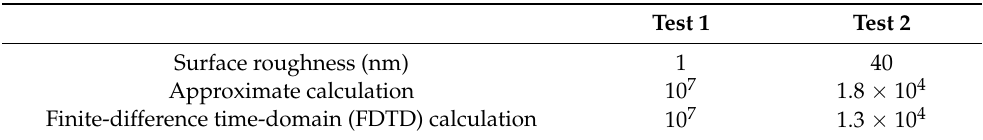
Table 2. The results of the calculated Q-factors of silicon disk resonators with different surface roughness